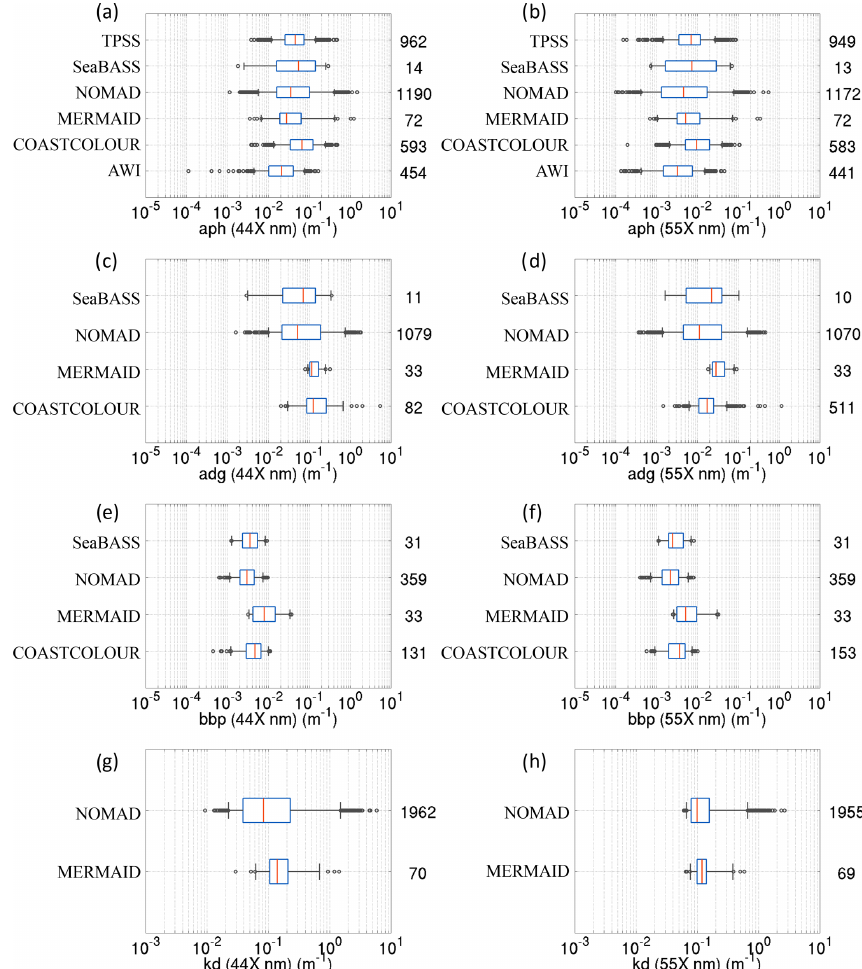
Figure 12. The distribution of (a) aph at 44 X nm, (b) aph at 55 X nm, (c) adg at 44 X nm, (d) adg at 55 X nm, (e) bbp at 44 X nm, (f) bbp at 55 X nm, (g) kd at 44 X nm, and (h) kd at 55 X nm. Data were first searched for at 445 and 555nm and then with a search window up to 8nm to include data at 547nm. The graphical convention is identical to Fig.